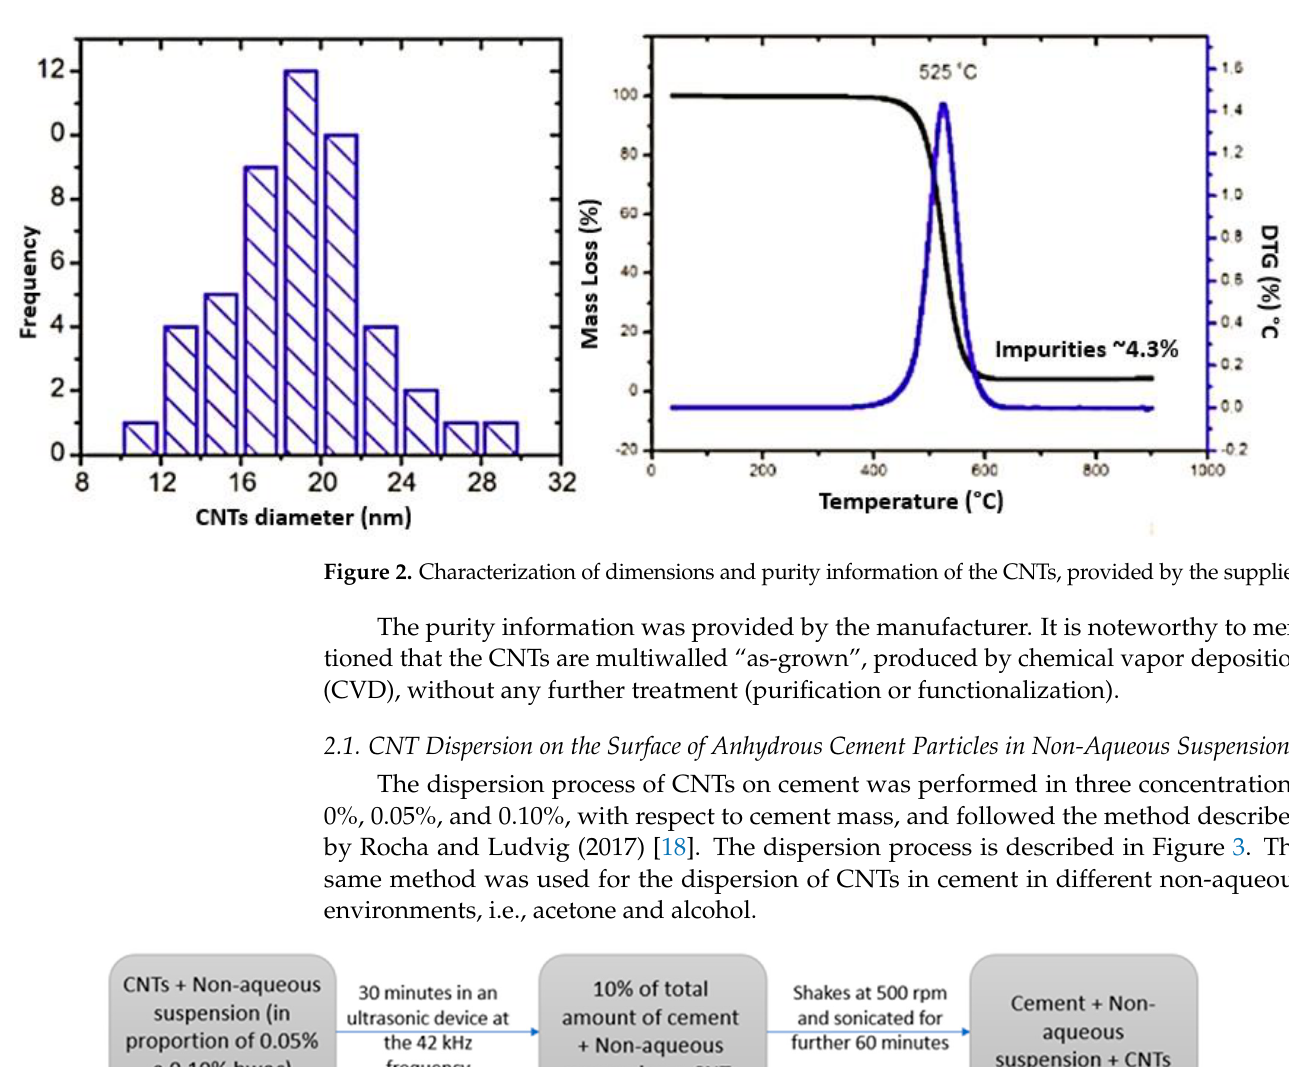
Figure 1. MEV and TEM images of CNTs used.